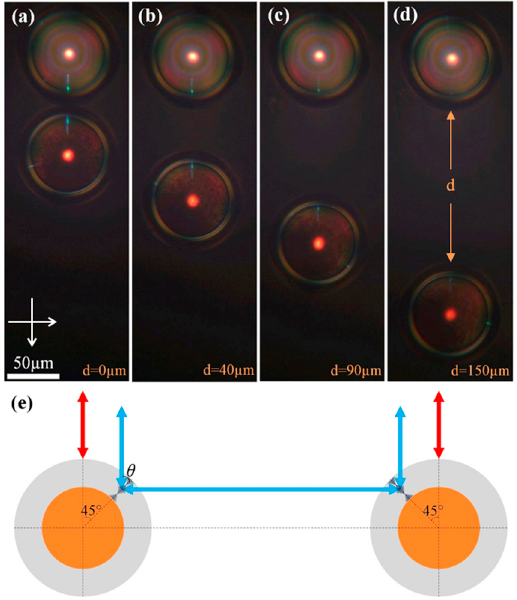
Figure 2. ( a – d ) Polarized optical microscope (POM) images of the cross-communication phenomenon with distance-dependent intensity. The cross arrow is the mutual position of crossed polarizer. ( e ) Schematic mechanism of the lateral reflection between two microshells.